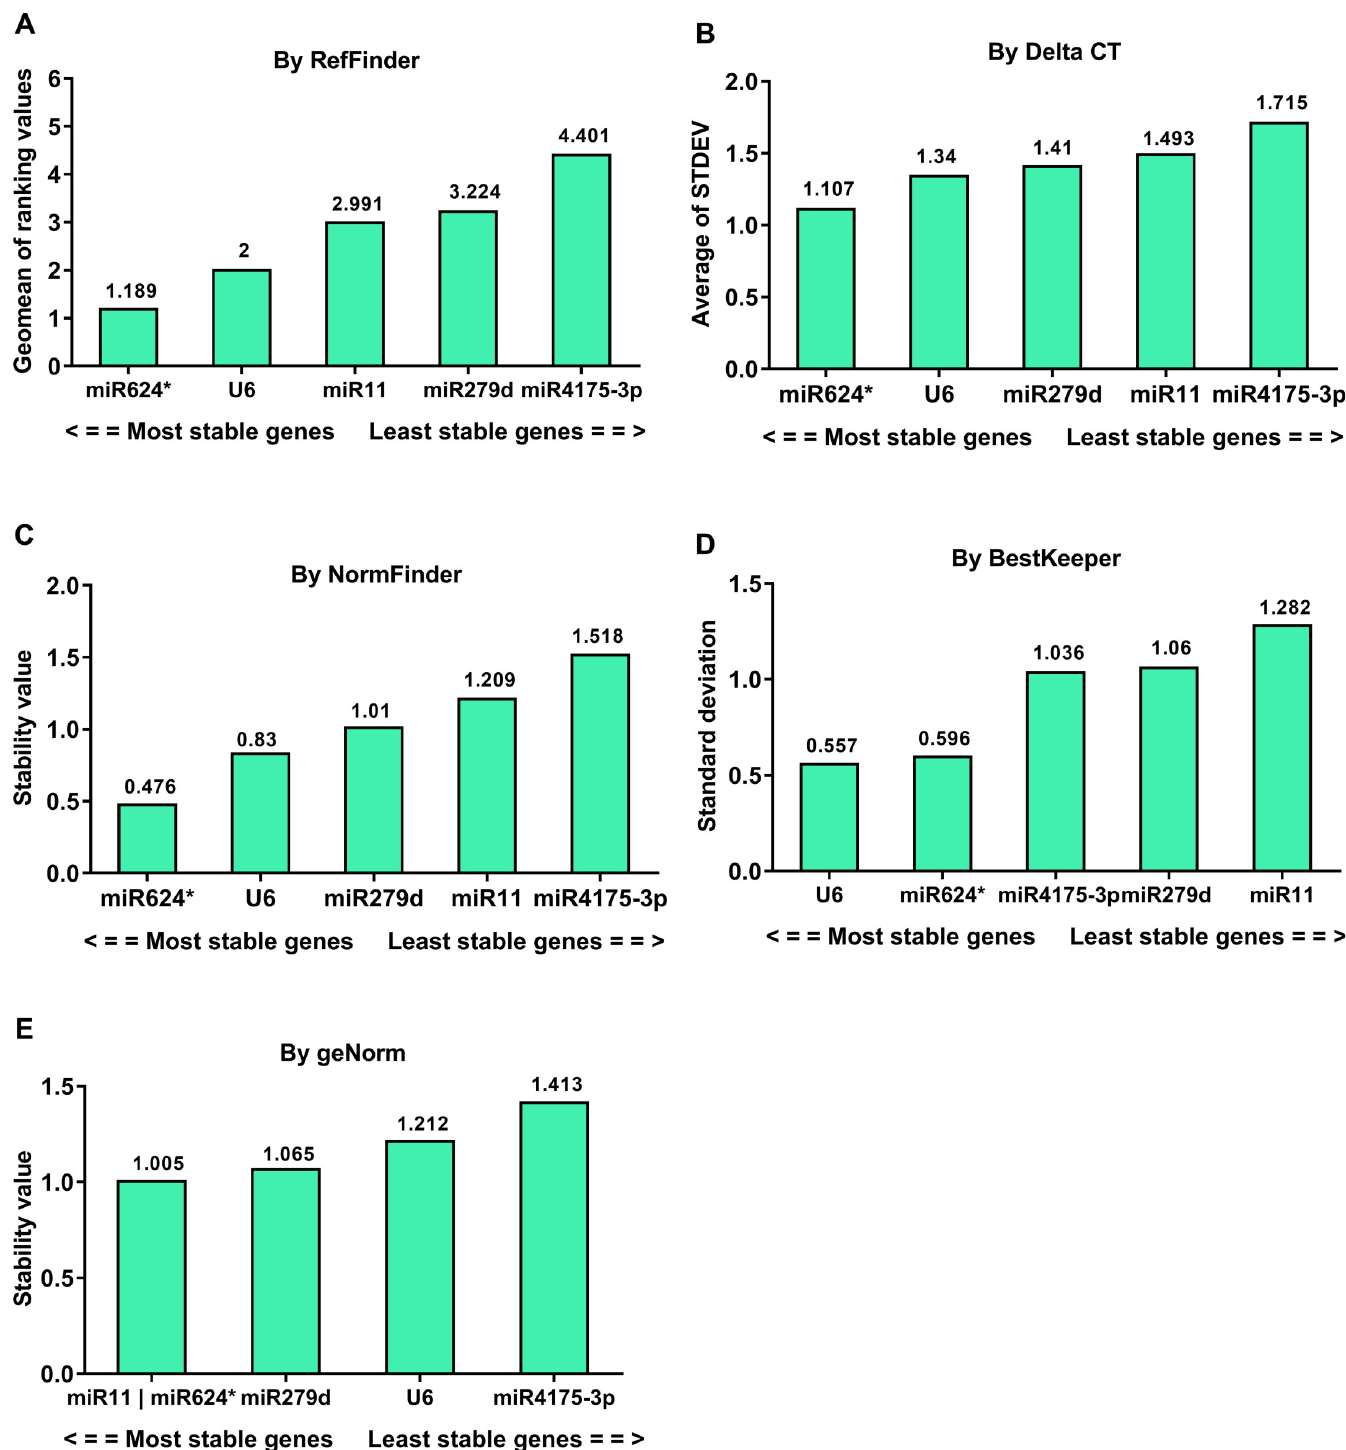
Fig 2. Stability analysis of candidate reference genes in the developmental stages of G88 strain. The Ct values derived from samples including first-day eggs, 1 st instar larvae, 2 nd instar larvae, 3 rd instar larvae, 4 th instar larvae, pupae and adults were used to calculate the stability values by different algorithms. A lower value indicates a more stable candidate gene as reference gene (numbers reported above the